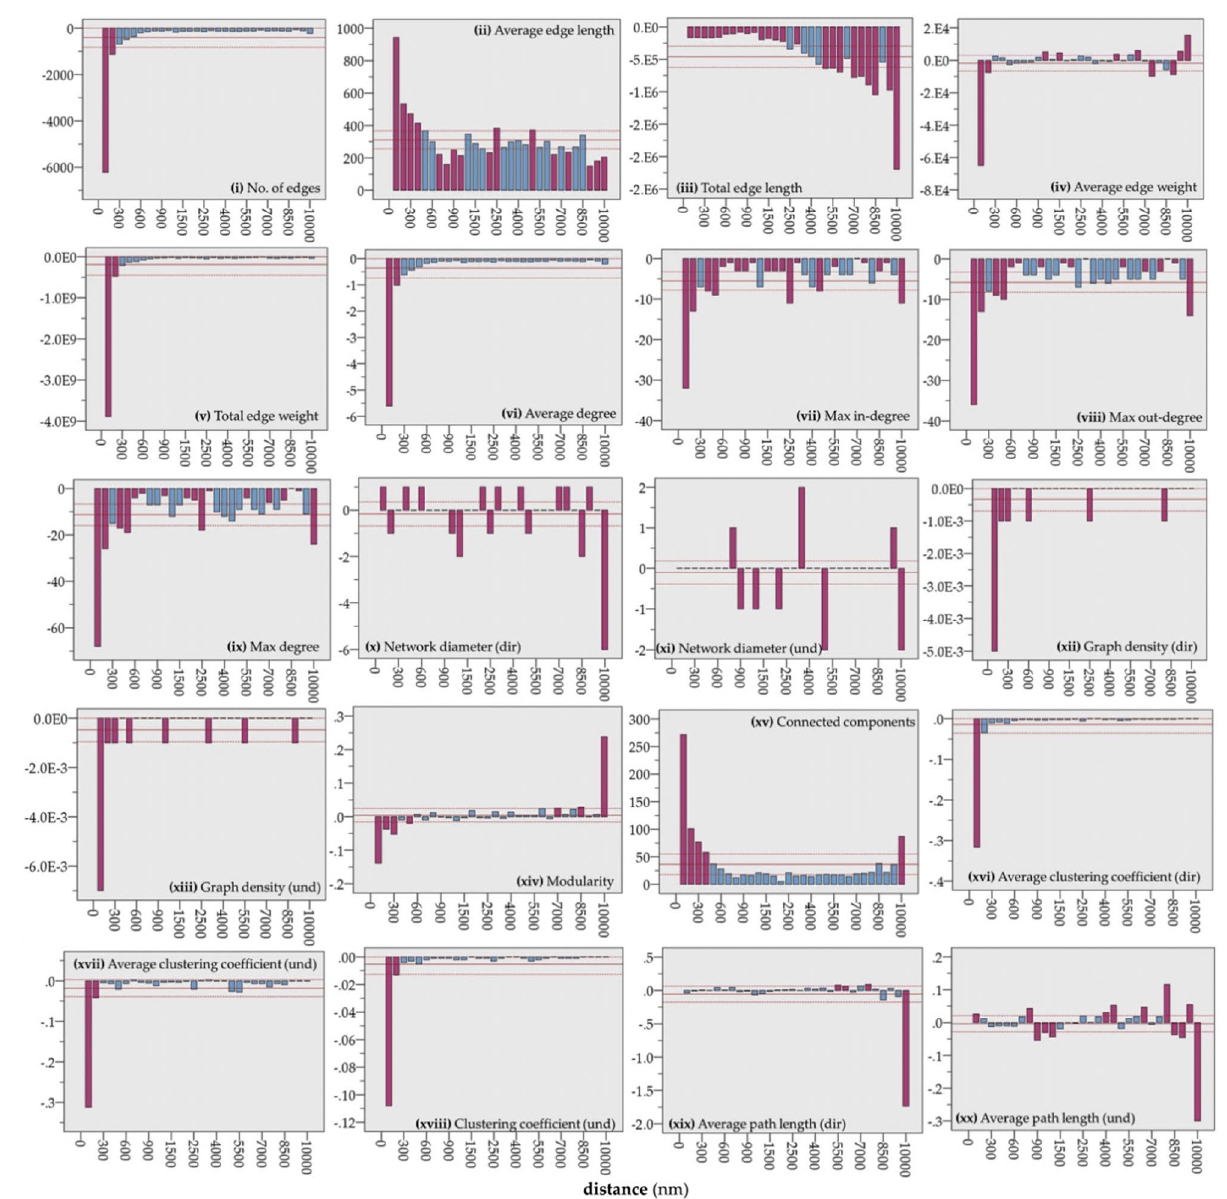
Figure 6. Bar plots (categorical axis) showing the first-order differences of the GCSN’s attribute-series of ( i ) network edges, ( ii ) average edge length (nm), ( iii ) total edge length (nm), ( iv ) average edge weight (DWT), ( v ) total edge weight (DWT), ( vi ) average degree, ( vii ) max in-degree, ( viii ) max out-degree, ( ix ) max degree, ( x ) network diameter (und, steps), ( xi ) network diameter (dir, steps), ( xii ) graph density (dir), ( xiii ) graph density (und), ( xiv ) modularity, ( xv ) connected components, ( xvi ) average clustering coefficient (dir), ( xvii ) average clustering coefficient (und), ( xviii ) clustering coefficient (und), ( xix ) average path length (und, steps), ( xix ) average path length (und, steps), which are expressed as a function of distance and are computed on the series of layers composing the multilayer model of GCSN (as shown in Fig. smoother decay at longer distances. Trade/gateway hubs like Antwerp, Rotterdam, and Yangshan have a higher interaction range than transshipment hubs such as Singapore, Algeciras, and Kaohsiung, which connectivity is more local due to the high frequency and multiplication of local linkages with feeder ports. A balanced profile was detected for Busan and Hong Kong, which are both gateway (hinterland) ports and hub (transshipment) ports. Also, the analysis revealed that bidirectional links in GCSN decrease with distance, highlighting the importance of asymmetric functionality in the carriers’ operations. According to their distribution of traffic over classes of distance, ports were classified into six clusters (local, short-range, short/medium-range, medium-range, medium/ long-range, and trans-scalar ports). Transcalar ports dominate the network when the latter is transformed into a tree-like structure revealing hubs and their belonged subgraphs. At last, the analysis on network measures verified the scale-free-like topology of the GCSN and illustrated a linear configuration of the GCSN in higher distances.